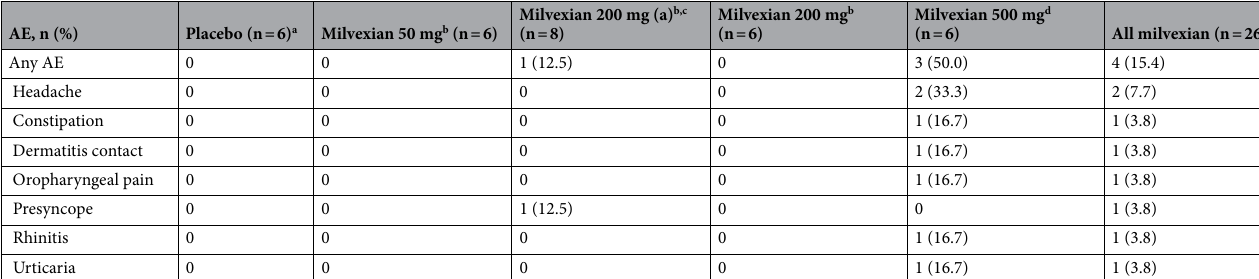
Table 2. Adverse events for all treated participants. AE, adverse event; PK, pharmacokinetics. a One participant in Cohort 3 (milvexian 500 mg or placebo) assigned to placebo was discontinued early due to participation in multiple clinical trials; this participant was excluded from analysis and replaced. b Milvexian 50 mg and 200 mg were administered under fasted conditions. c Cohort 2a, milvexian 200 mg (a), includes unblinded and early terminated participants from Cohort 2 (milvexian and placebo participants). These participants were excluded from the evaluable PK population. d Milvexian 500 mg was administered under fed conditions.